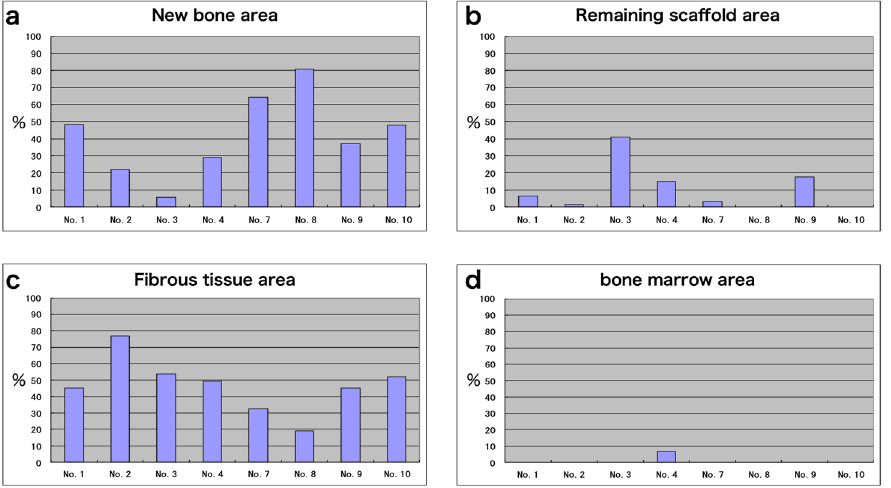
Figure 8 . Histomorphometric analysis of bone biopsy samples at 6 months after transplantation: ( a ) new bone area, ( b ) remaining scaffold area, ( c ) fibrous tissue area, and ( d ) bone marrow area, expressed as a percentage of the total area.